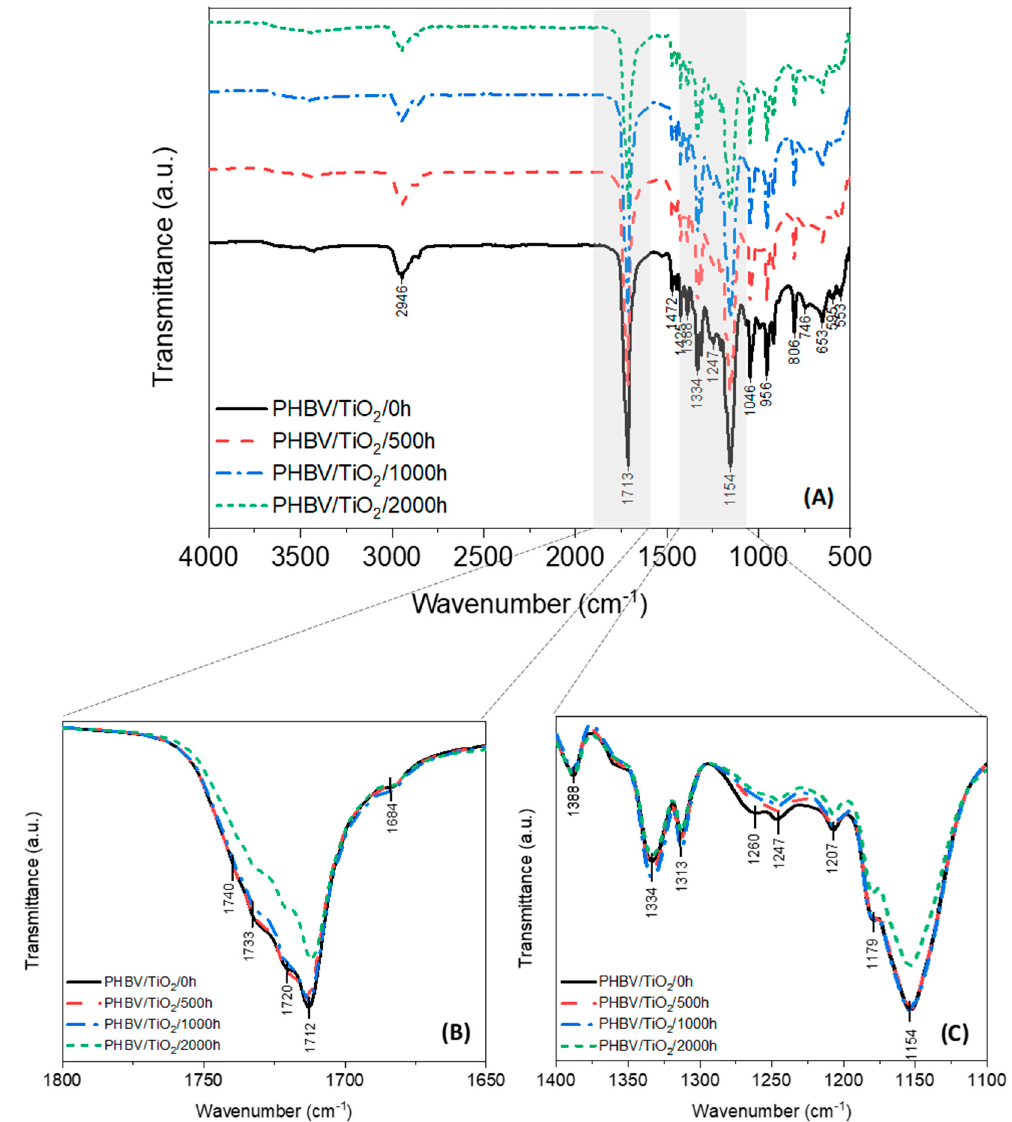
Figure 7. FTIR spectra of the PHBV/TiO 2 nanocomposites before (0 h) and after (500, 1000 and 2000 h) accelerated weathering ( A ). Detailed area of: the stretching C=O vibration ( B ), the CH 3 deformations (1338 cm − 1 ), and the stretching C–O (1255 − 1245 cm − 1 and 1180 cm − 1 ) bands ( C ).